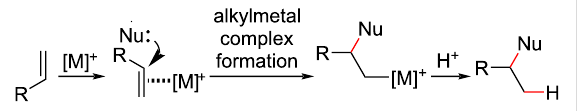
Interest is currently growing in increasing the molecular com- plexity of drugs in drug discovery programs, aiming at mole- cules with better selectivity for biological targets [6,15,16]. One ideal way to achieve more complex molecular architectures is by hydroalkylation of olefins, a reaction that forms new C(sp 3 )–C(sp 3 ) and C(sp 3 )–H bonds at the expense of a double bond by increasing the Fsp 3 with the concomitant formation of carbon quaternary